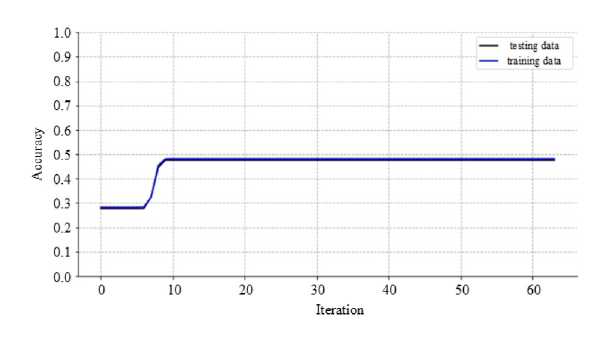
FIGURE 18 Accuracy of FFT-LSTM-dropout network.